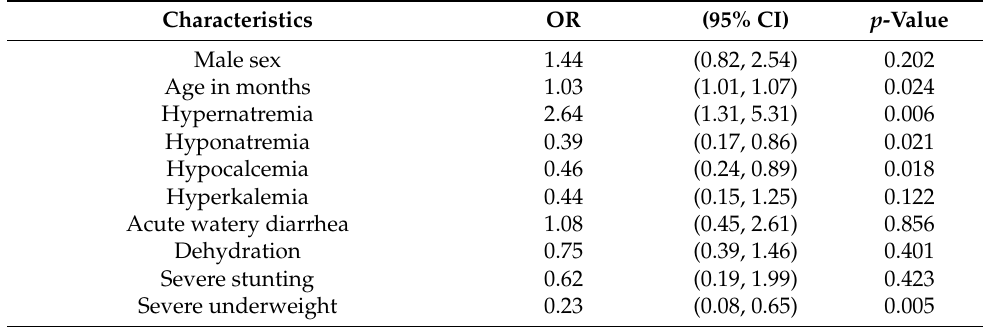
Table 4. Logistic regression analysis revealing the independently associated factors for adopting a no antibiotic approach in under-five ICU children in